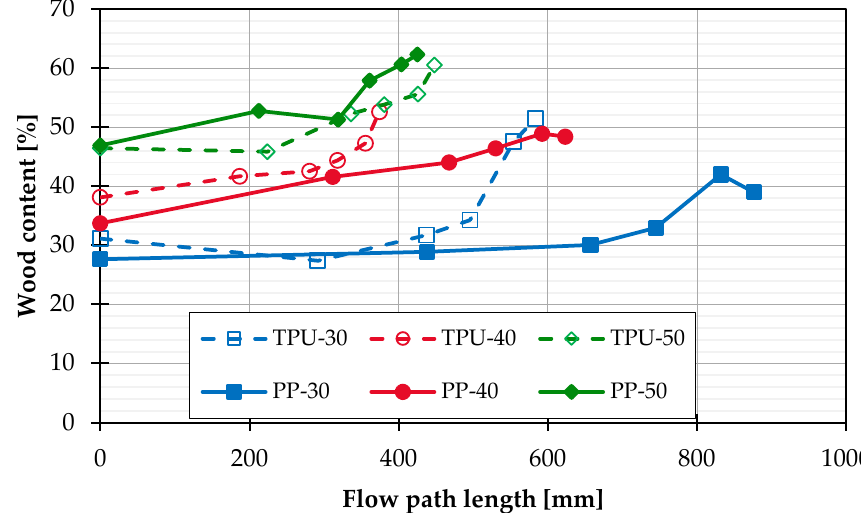
Figure 4. Absolute wood content over absolute flow path length as a function of matrix material (TPU, PP) and wood content (30, 40, 50 wt.%) at a melt temperature of 190 °C and a mold temperature of 60 °C.